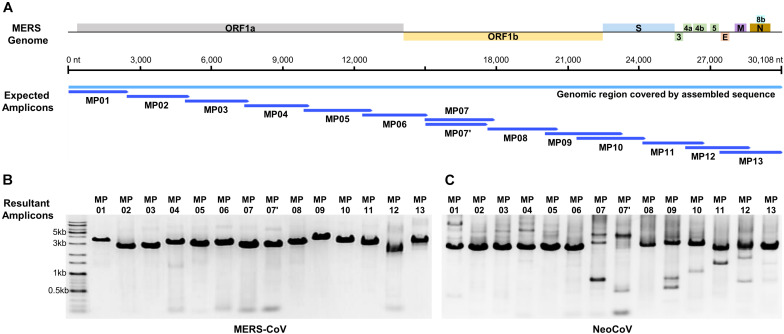
Graphical summary of the designed primer sets and the results of the genome amplification. (A) Localization of designed amplicons on the MERS-CoV genome. (B) PCR result of MERS-CoV genome amplification. (C) PCR result of NeoCoV genome amplification.